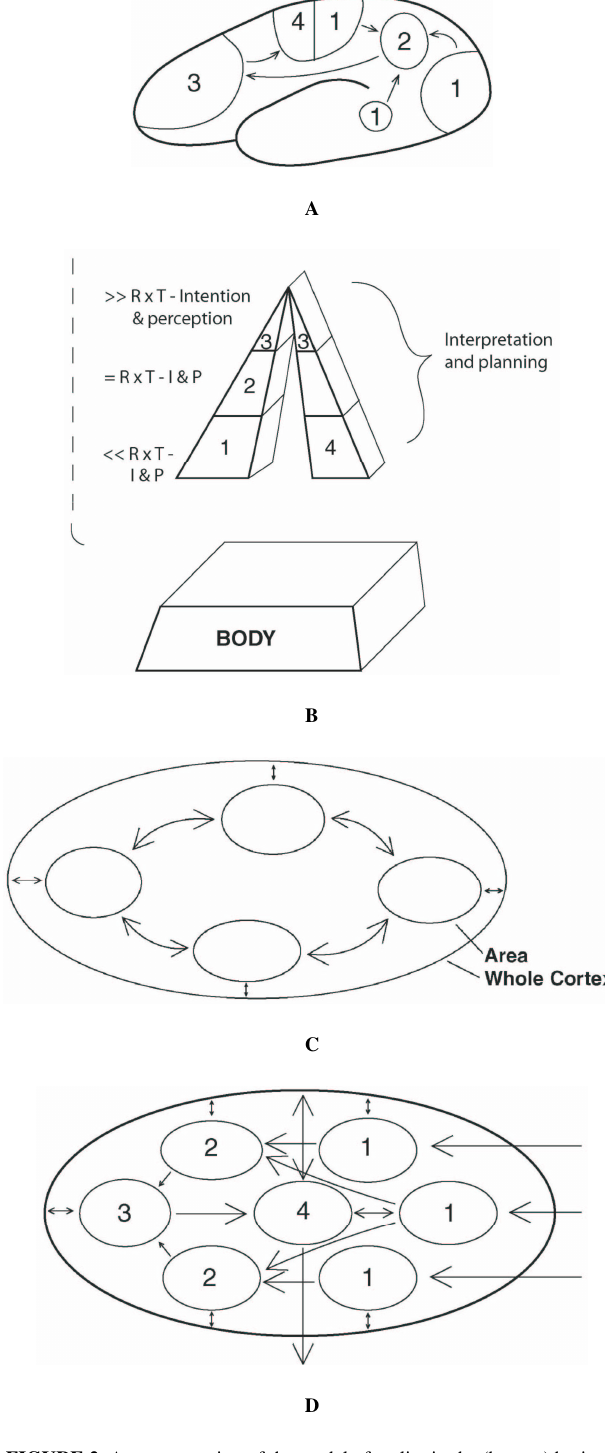
FIGURE 2. A representation of the model of reality in the (human) brain as a consequence of a double hierarchy. (A) Parts of the brain that interact